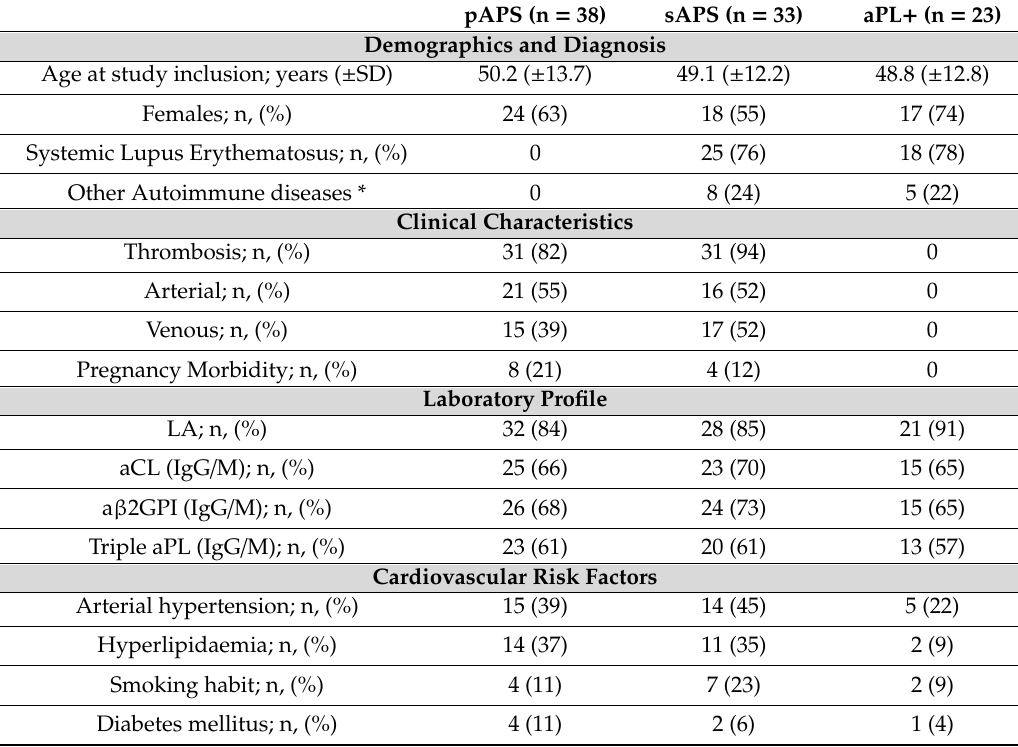
Table 1. Main demographic, clinical and laboratory characteristics of the patients included in the